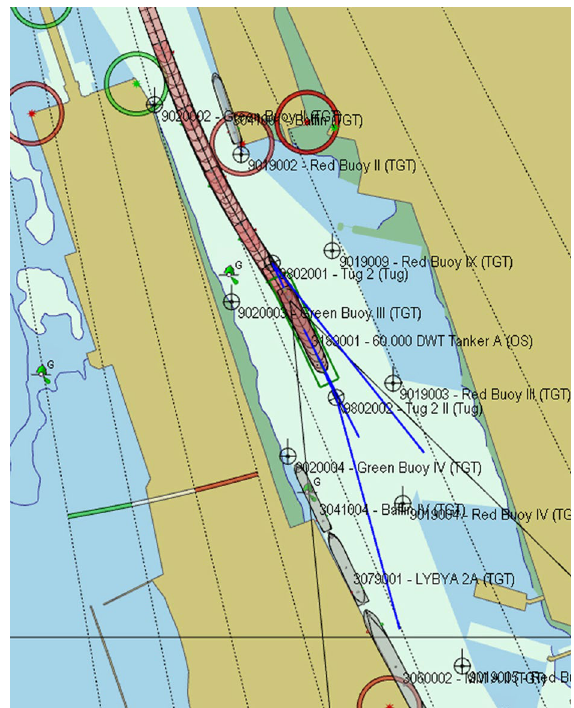
Fig. 4. Ship entry to the turning basin in Malkų Bay (electronic map)